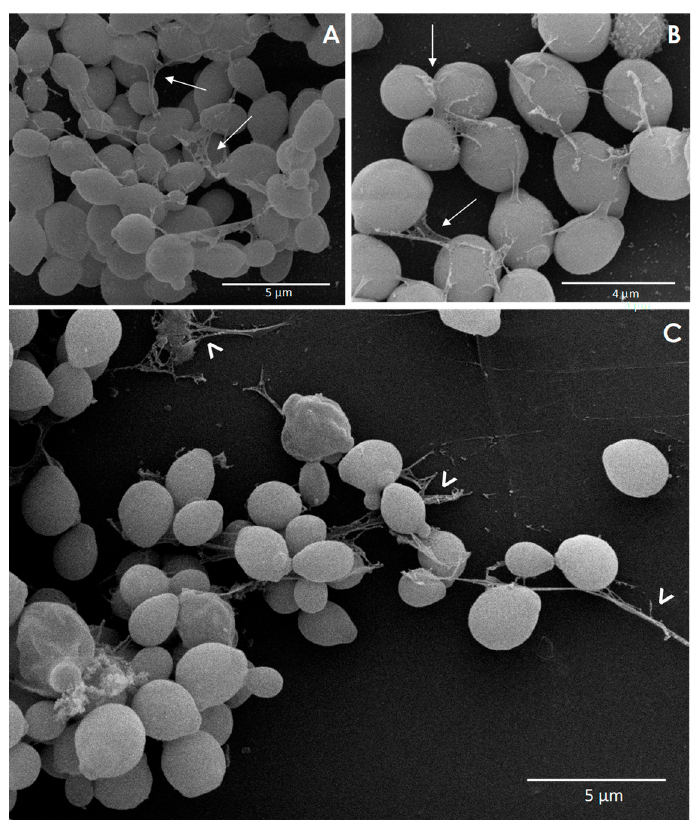
Figure 4. Representative high-magnification SEM images of the biofilms formed by the C. haemulonii species complex on polystyrene surface, focusing on the extracellular matrix (ECM). Yeasts (200 µL containing 10 6 cells) were placed to interact with polystyrene coverslips for 48 h at 37 °C, after which the coverslips were visualized using SEM. The ECM of biofilms of C. haemulonii LIP Ch 4 ( A ), C. duobushaemulonii LIP Ch 6 ( B ), and C. haemulonii var. vulnera LIP Ch 5 ( C ) are indicated by symbols. The